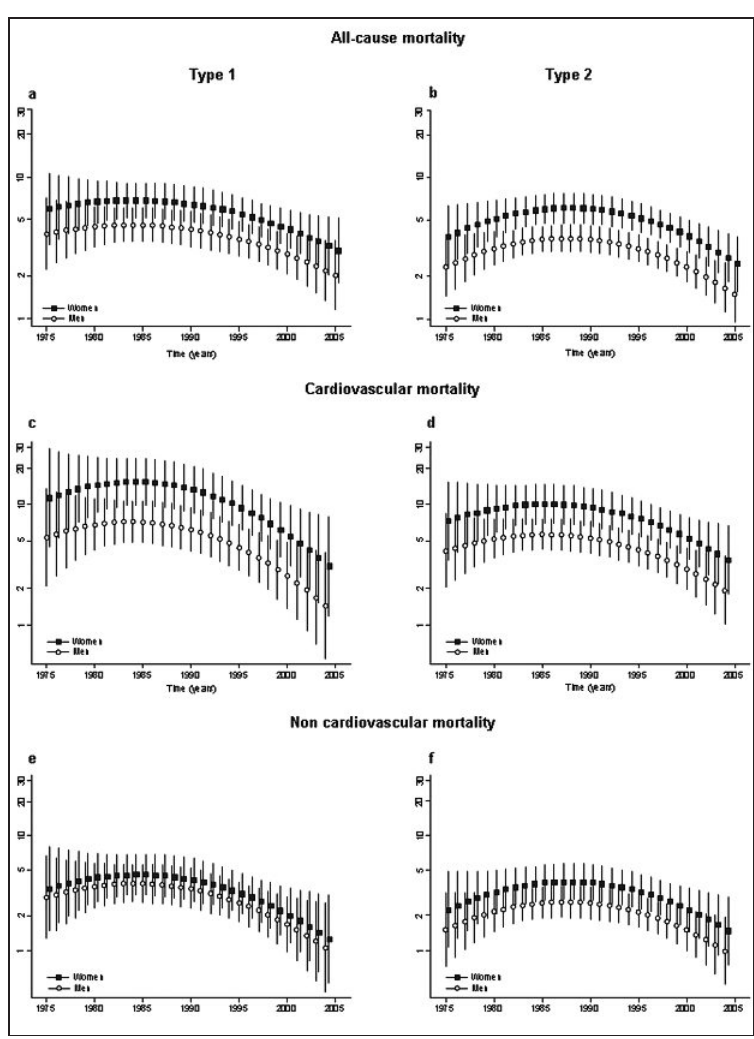
Figure 2 Fitted SMRs according to type of diabetes and sex for all-cause mortality (Panels a and b), cardiovascular mortality (Panels c and d), and non-cardiovascular mortality (Panels e and f). SMRs were modelled using a Poisson-regression model including sex and the calendar year (centered at 1990) as linear and quadratic